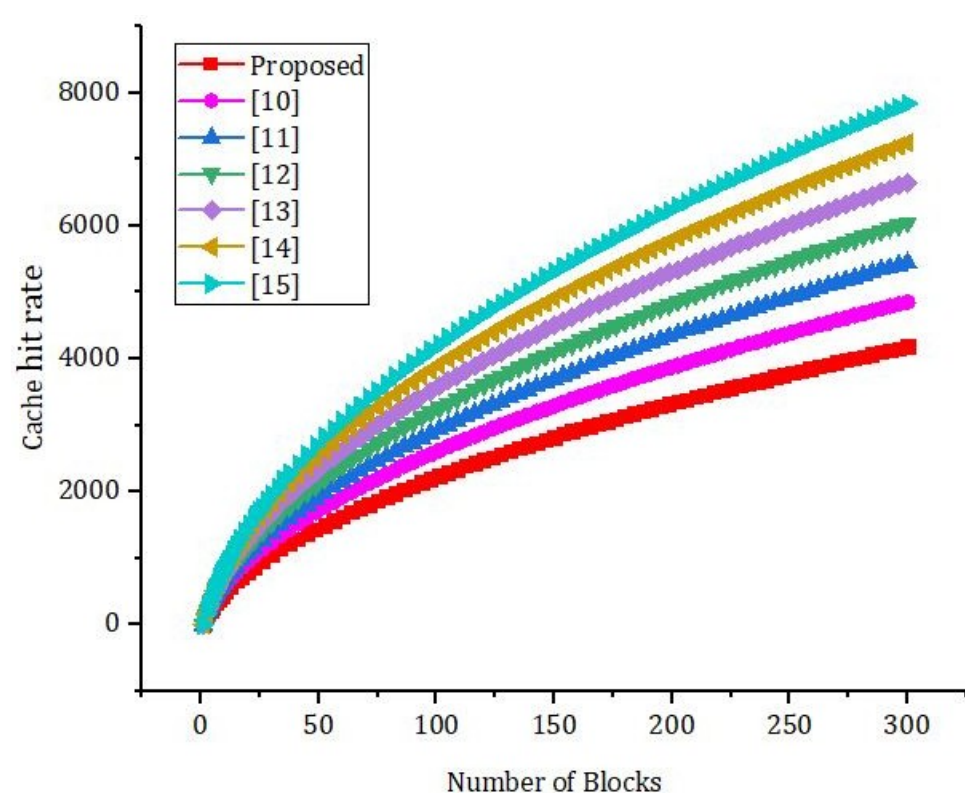
Figure 13. Simulation results based on the bandwidth and number of rounds.